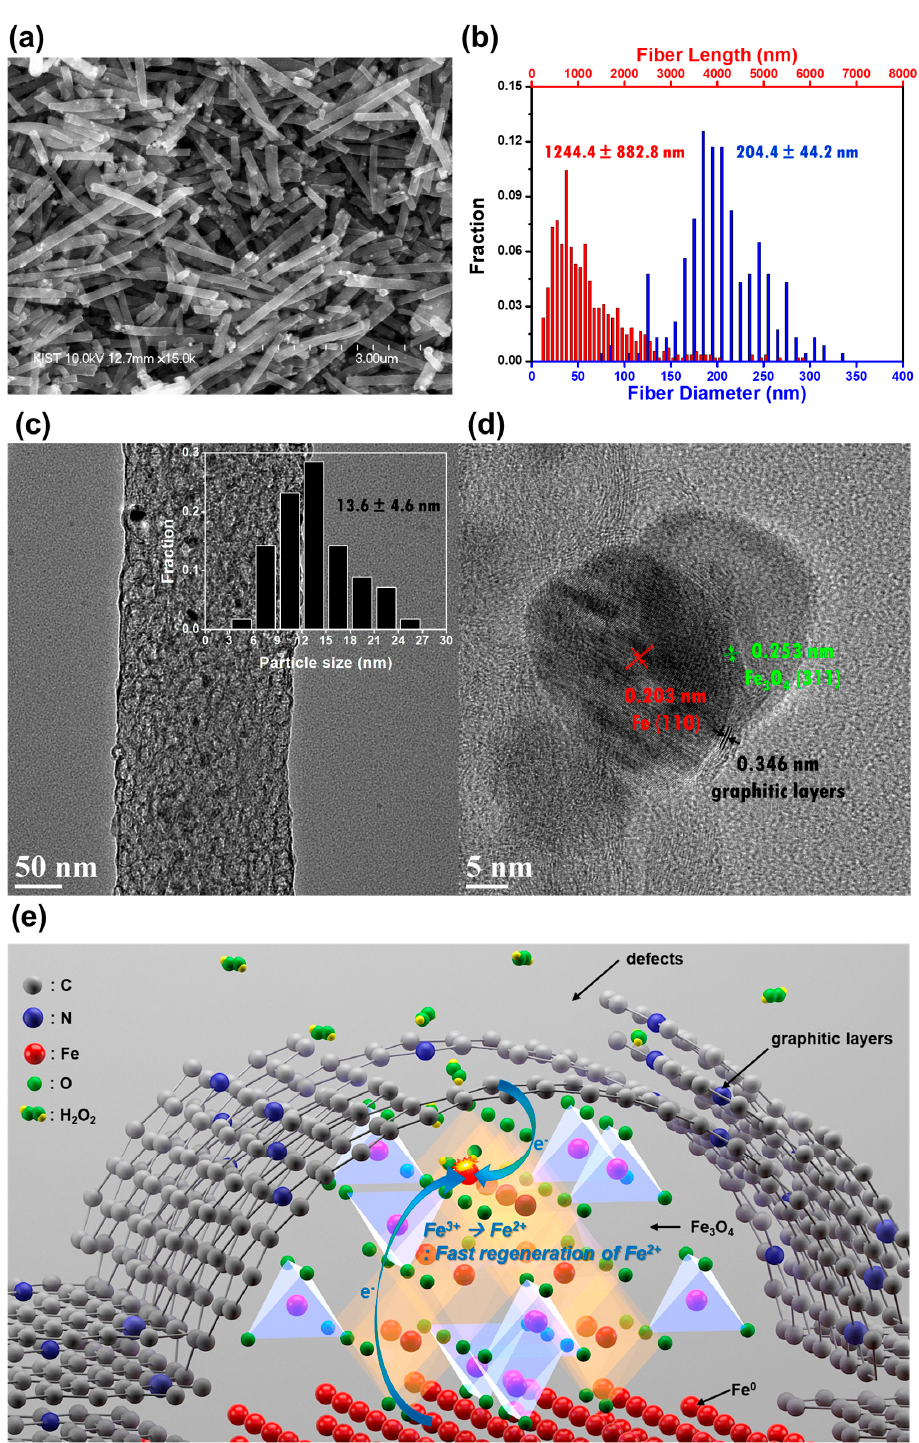
Figure 3. SEM image of Fe 3 O 4 /Fe/Fe 3 C@PCNF, ( b ) The distribution of length and diameter of fibers in ( a ), ( c ) Low-magnification TEM image of Fe 3 O 4 /Fe/Fe 3 C@PCNF. Dark spots correspond to the catalyst nanoparticles dispersed throughout PCNF. The inset displays the size distribution of these nanoparticles. ( d ) High-magnification TEM image of the vicinity of catalyst particles positioned at the outermost edge of PCNF. ( e ) The suggested mechanism of extremely fast H 2 O 2 catalytic decomposition by Fe 3 O 4 /Fe/Fe 3 C@PCNF. Reproduced with permission from RSC from [58].